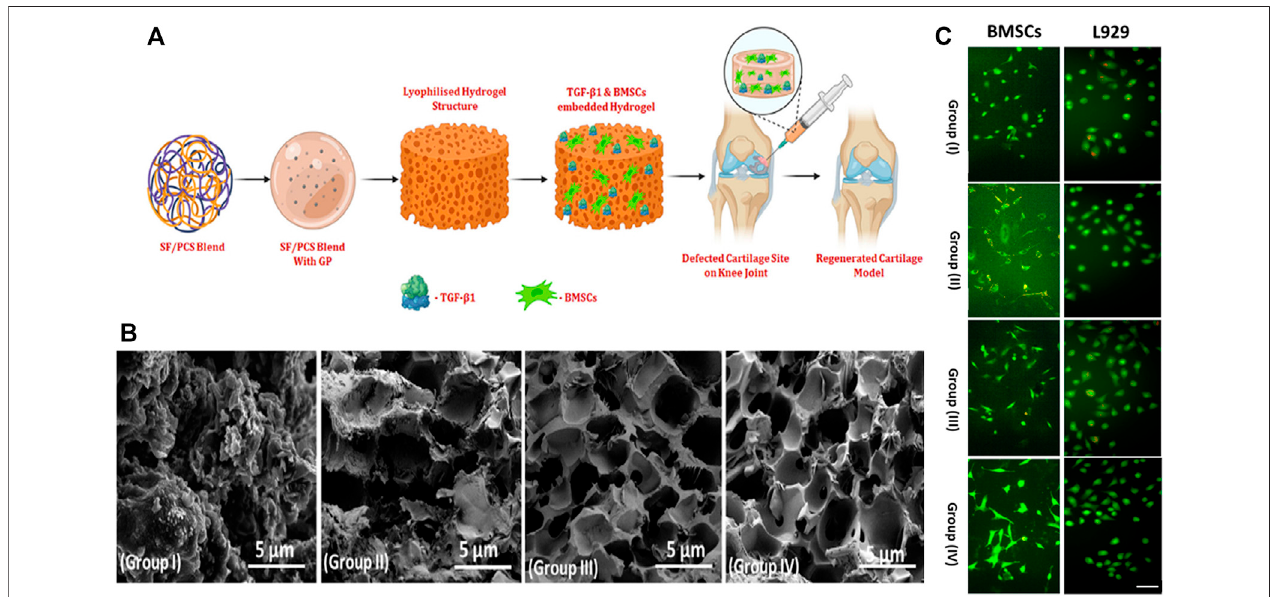
FIGURE 3 | (A) Schematic illustration of BMSCs and TGF- β 1 encapsulated SF/PCS injectable hydrogel for cartilage repair; (B) The morphological of prepared hydrogelgroupswithdifferentblendingratioswereobservedandvisualizedbySEManalysis; (C) FluorescencemicroscopicobservationofBMSCsandL929seededon different hydrogels after 24 h incubation. Reproduced from Zheng et al. (2021) with permission from Copyright 2022